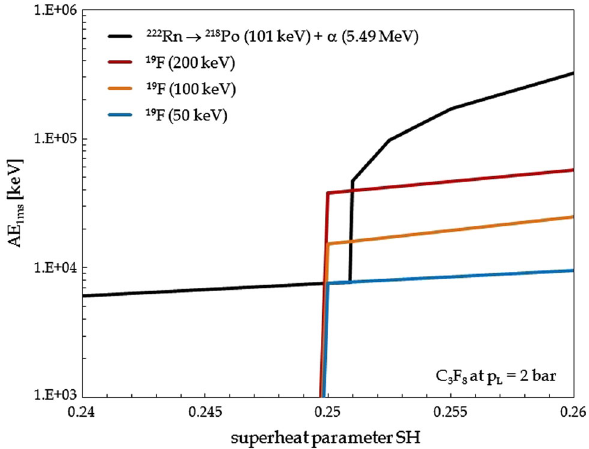
Fig. 11 Close-up of the distributions of AE 1ms in Log-scale vs. SH for alpha decays and nuclear recoils in C 3 F 8 at p L = 2